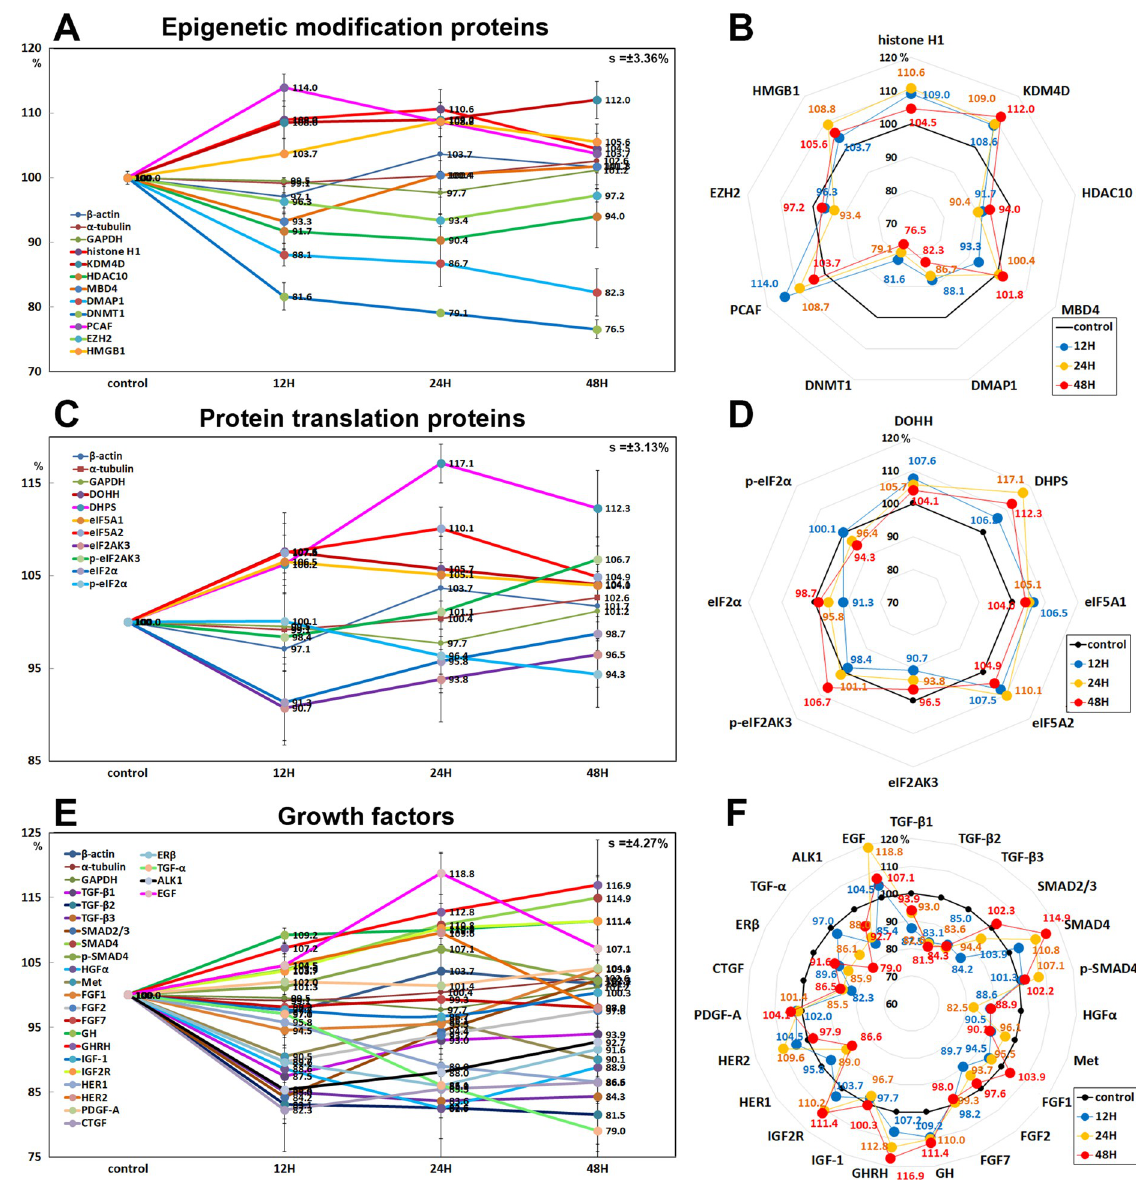
Fig 10. Expression of epigenetic modification proteins (A and B), protein translation proteins (C and D), and growth factors (E and F) in 10 μ g/mL PTX-treated RAW 264.7 cells as determined by IP-HPLC. Line graphs, A, C, and E show protein expression on the same scale (%) versus culture time (12, 24, or 48 h), whereas the star plots (B, D, and F) show the differential expression levels of the proteins at 12, 24, or 48 h after PTX treatment on the appropriate scales (%). The thick black line, untreated controls (100%); the blue, yellow, and red dots show differential protein levels after PTX administration for 12, 24, or 48 h,